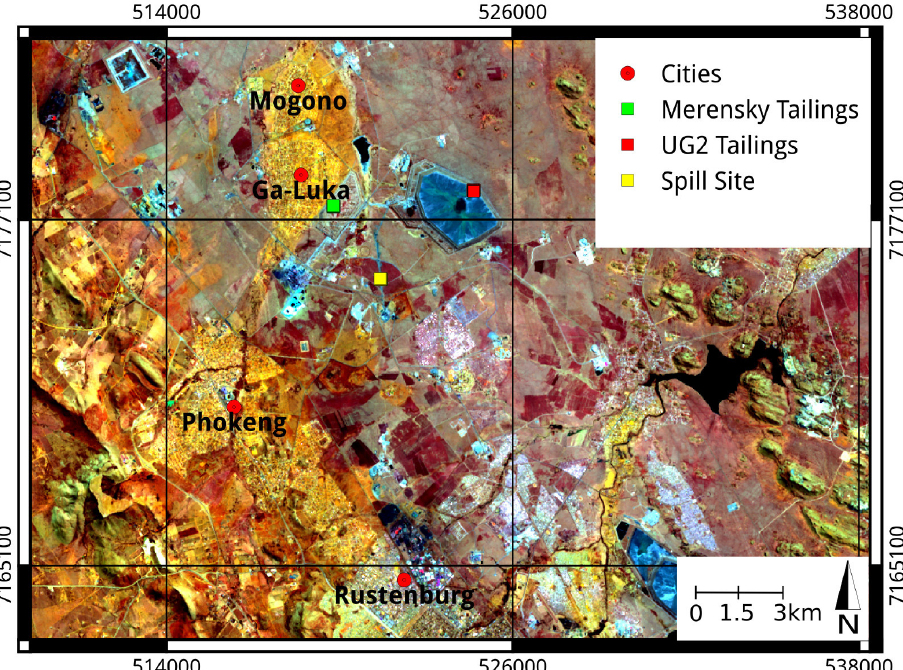
Figure 2. Landsat 8 composite (R: 2200 nm, G: 655 nm, B: 482 nm) showing the tailings facilities and test sites (colored stars) visited in the field area near